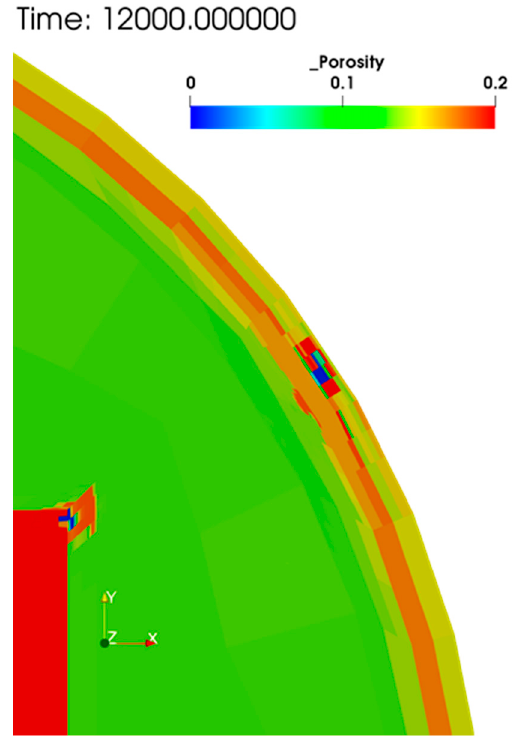
Figure 17. Porosity profile at 12,000 years (2000 years after crack appearance).